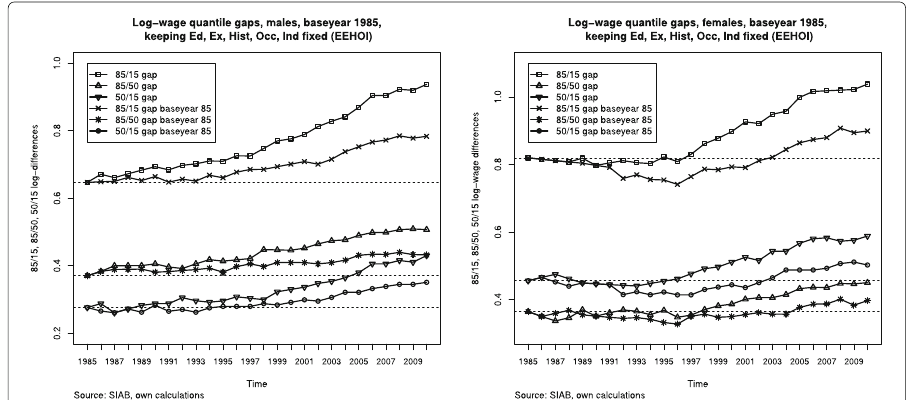
Fig. 13 Inequality development base year 1985, specification EEHOI (education, experience, labor market history, occupation, industry sector)